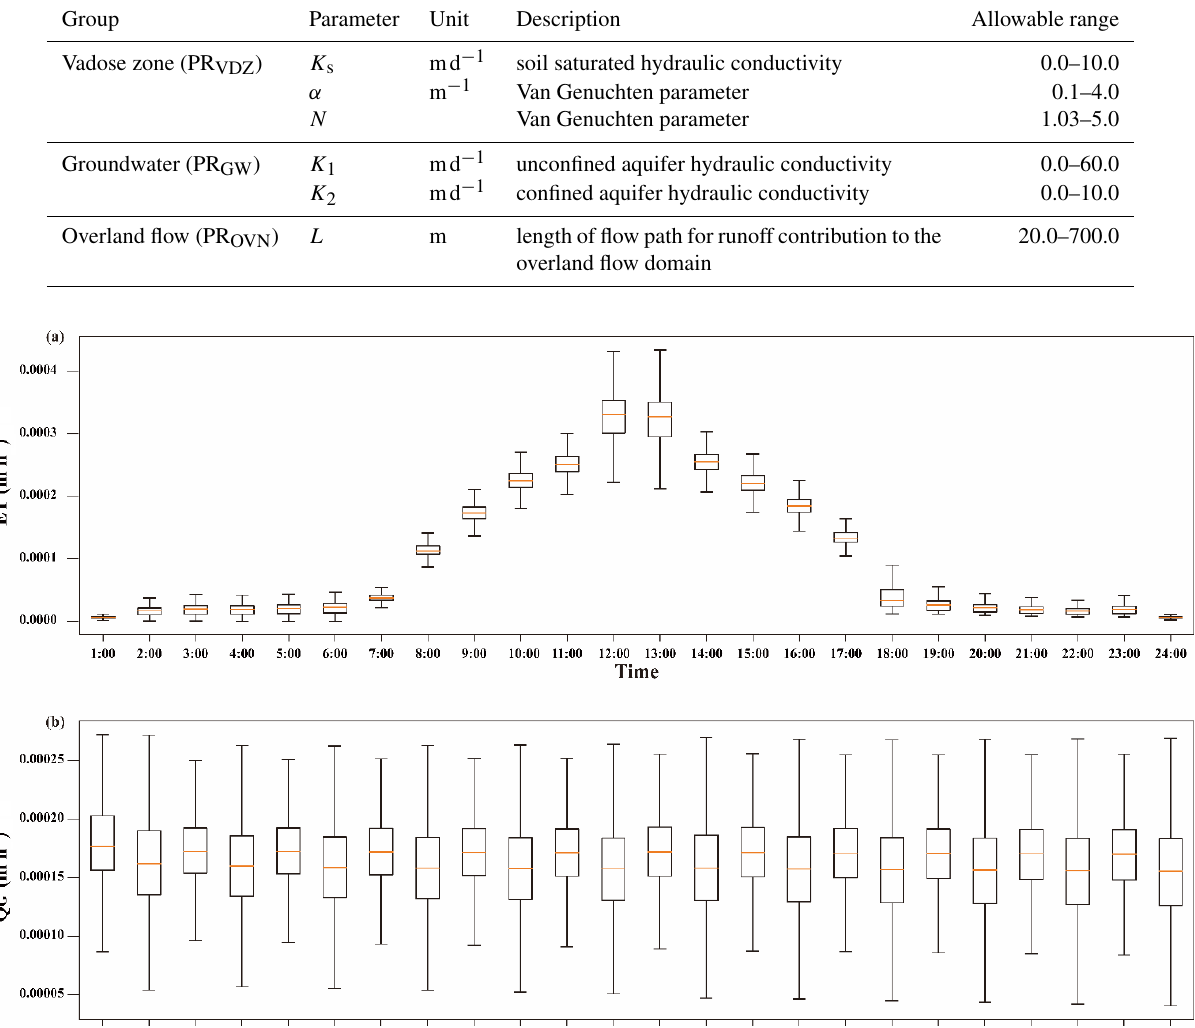
Table 2. Six chosen parameters to be included in parameter uncertainty.